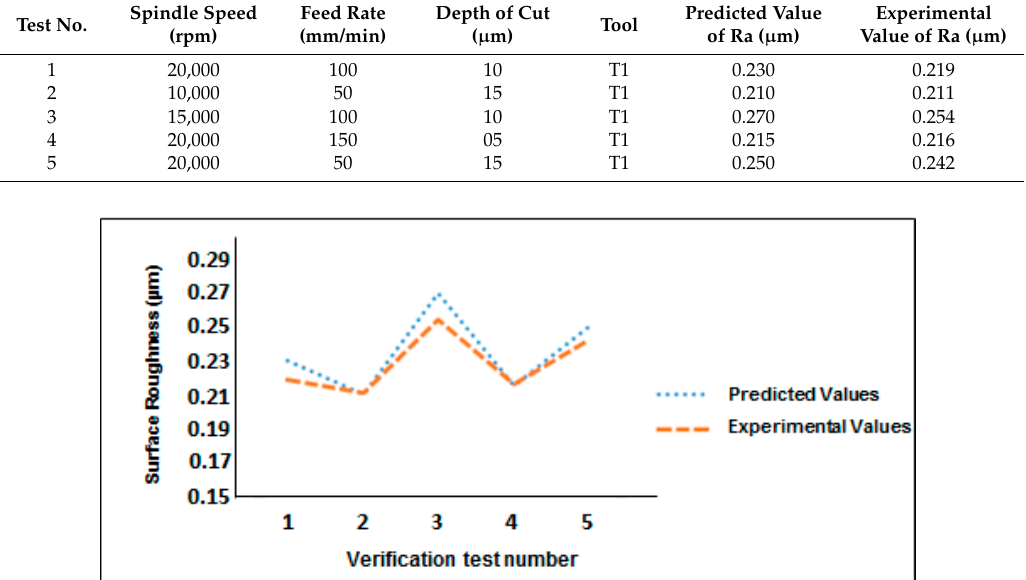
Table 5. Verification test.